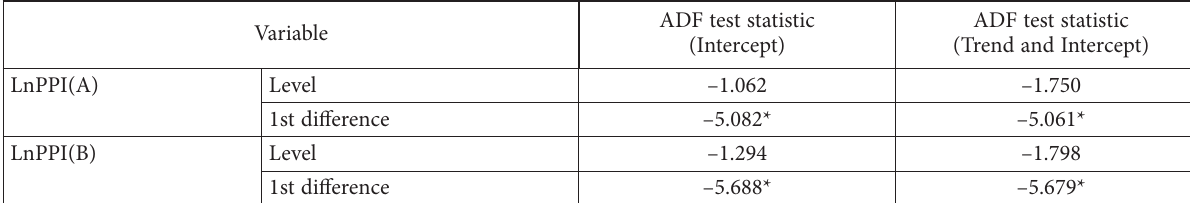
Table 2. The Augmented Dickey-Fuller test